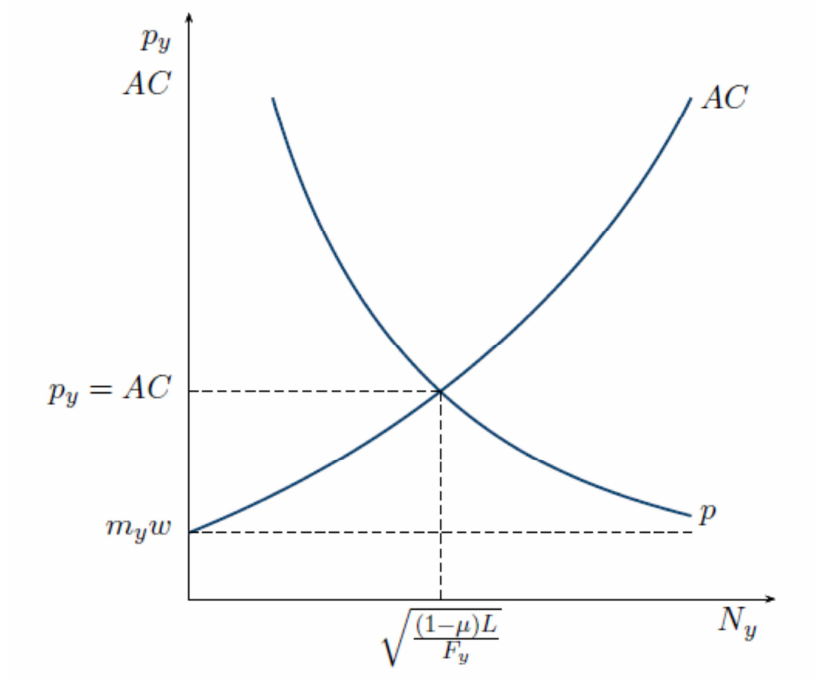
Figure 2. Equilibrium in the market for homogenous